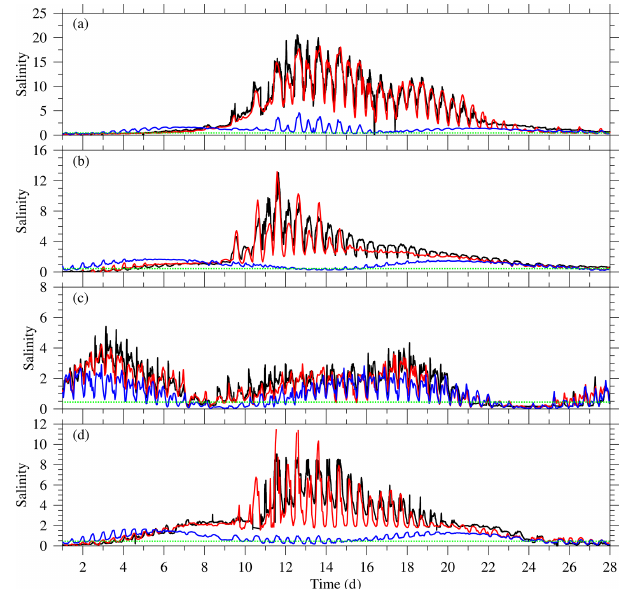
Figure 3. Temporal variations in salinity in February 2014 at hydro- logic stations. (a) Baozhen station, (b) Nanmen station, (c) Chongxi station and (d) Qingcaosha station. Black line – measured salinity; blue line – simulated salinity under climatic wind and residual wa- ter level conditions at open sea boundaries (experiment 1); red line – simulated salinity under a realistic wind and residual water levels at the open sea boundaries (experiment 2). The dashed green line represents salinity of 0.45, which is the standard for drinking water.